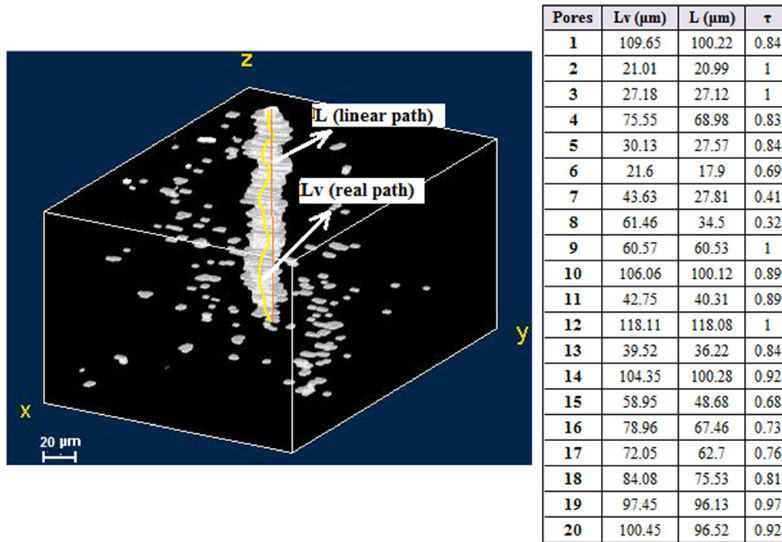
Figure 8. Example of tortuosity parameter calculation using 3D reconstructed images of large